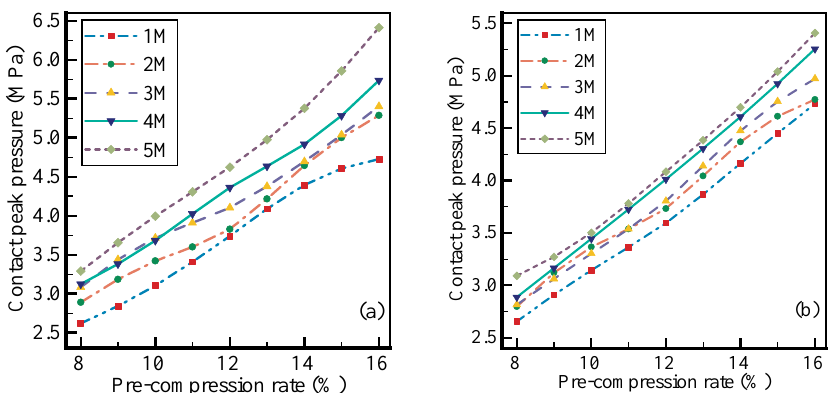
Figure 9. Comparison of pre-compression rate. The contact peak pressure under nine different pre-compression rates are shown in ( a ) for piston rod side and in ( b ) for groove side. Five groups simulation are compared, with five sealing rings of different section diameters coded from 1 to 5. And M represents for zero hydraulic pressure.